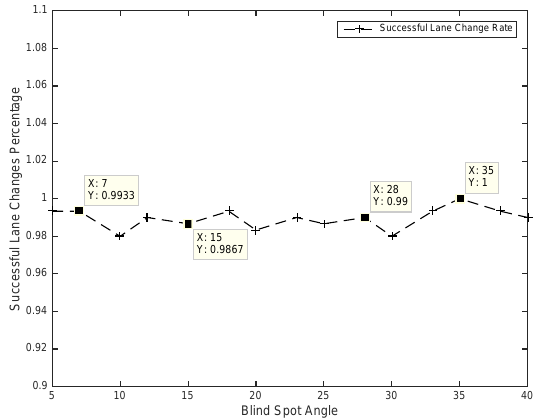
Figure 8. The fraction of successful lane change function of the angle of the blind spot in the presence of V2V communication.